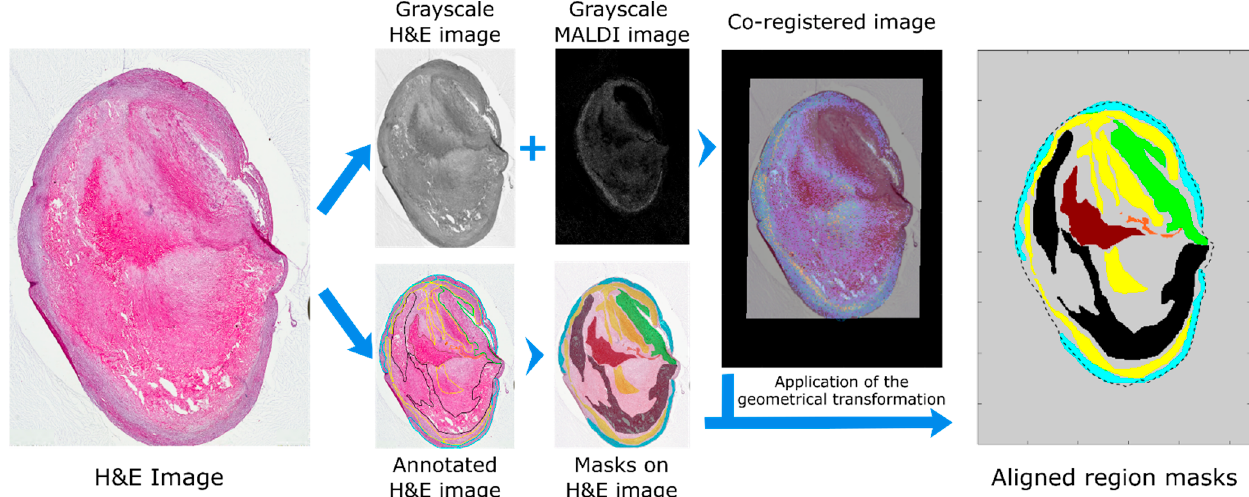
Figure 2. Workflow for transfer of molecular and histological annotations to MALDI MSI datasets. The histological images were imported into MATLAB, resized and rotated to approximately match the MALDI MSI datasets and saved as a grayscale image. The resulting image is co-registered to a user defined MS image and all parameters of the transformation saved. The coordinates of the annotated regions are imported into MATLAB and converted into masks with the command poly2mask . The same geometrical transformation used for the co-registration was then applied to register the region masks to the MALDI MSI dataset. Regions present in the plaque were hemorrhage (brown), lipid-necrotic core (black), collagen (yellow), macrophages (orange), outer VSMCs (cyan) and inner VSMCs (green).